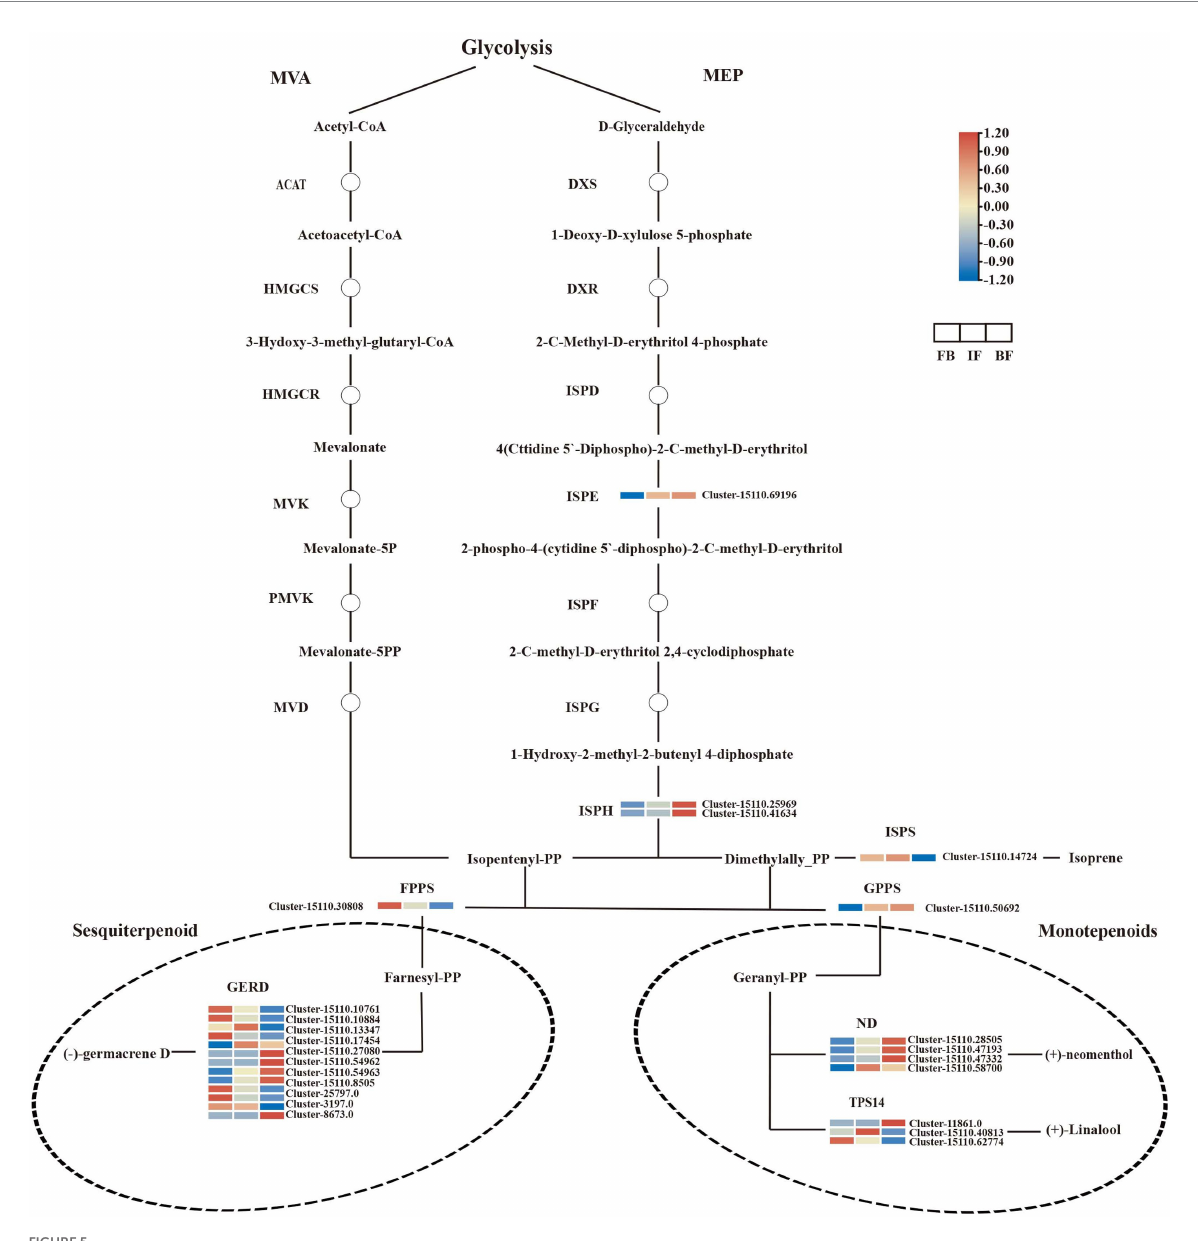
FIGURE 5 Expression heatmaps of genes associated with terpenoid biosynthesis in Chrysanthemum indicum var. aromaticum flowers at three developmental